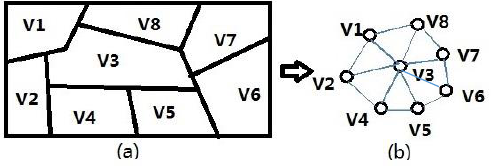
Fig. 3 Image objects and corresponding